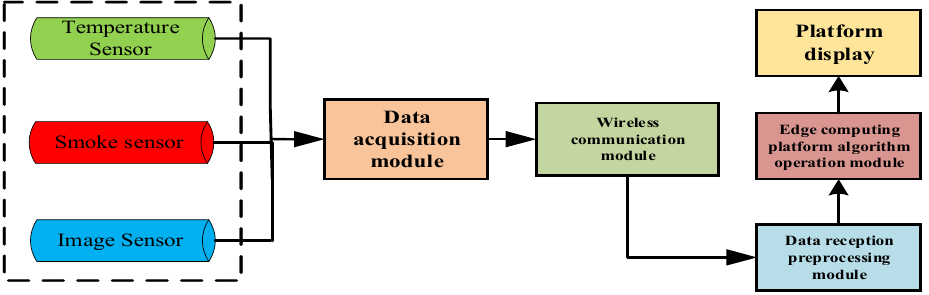
Figure 3. Sensor and data processing structure diagram.